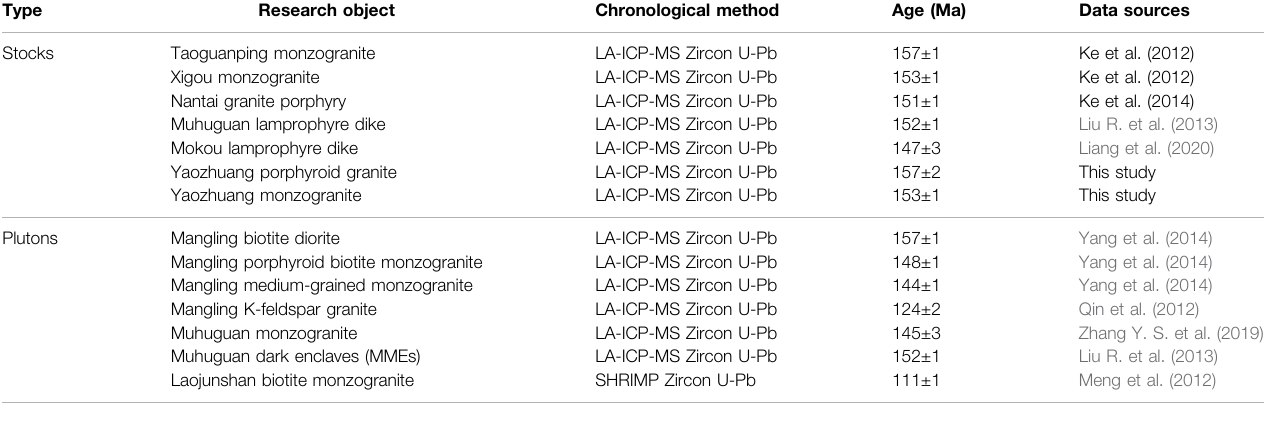
TABLE 4 | Age statistics of granitic batholith and stocks in the North Qinling.